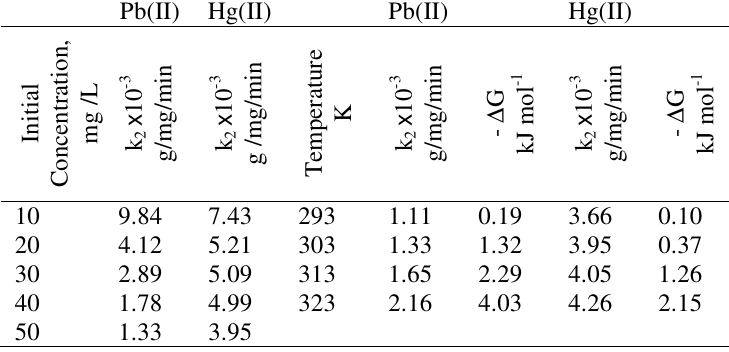
Table 1. Pseudo second-order rate constants and thermodynamic parameters for Pb(II) and